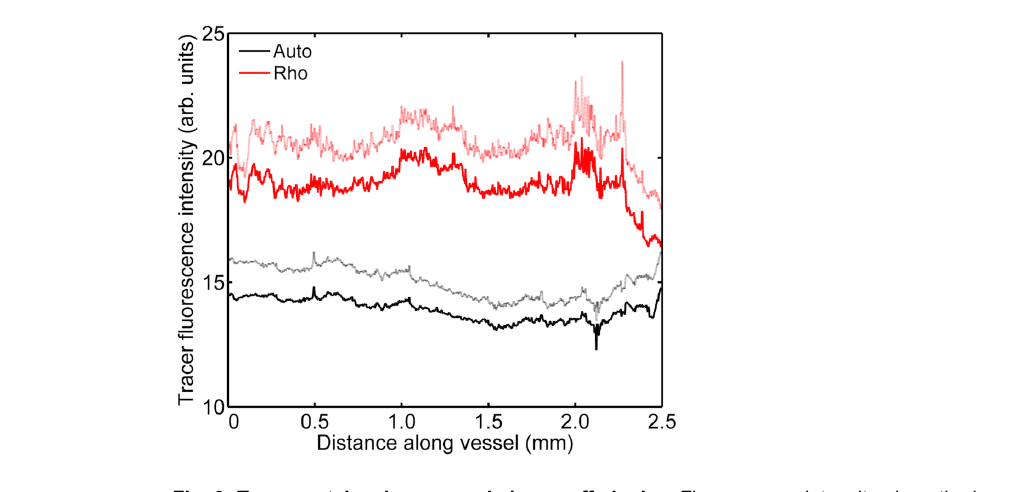
Fig. 9. Tracer uptake along vessels in uncuffed mice. Fluorescence intensity along the length of carotid arteries of mice without cuffs; data from left and right carotids have been combined. Rhodamine-labelled tracer was administered to the mice (‘‘Rho’’) or was omitted to assess autofluorescence (‘‘Auto’’). Mean (dark line) + 1 SEM (light line), n 5 4.